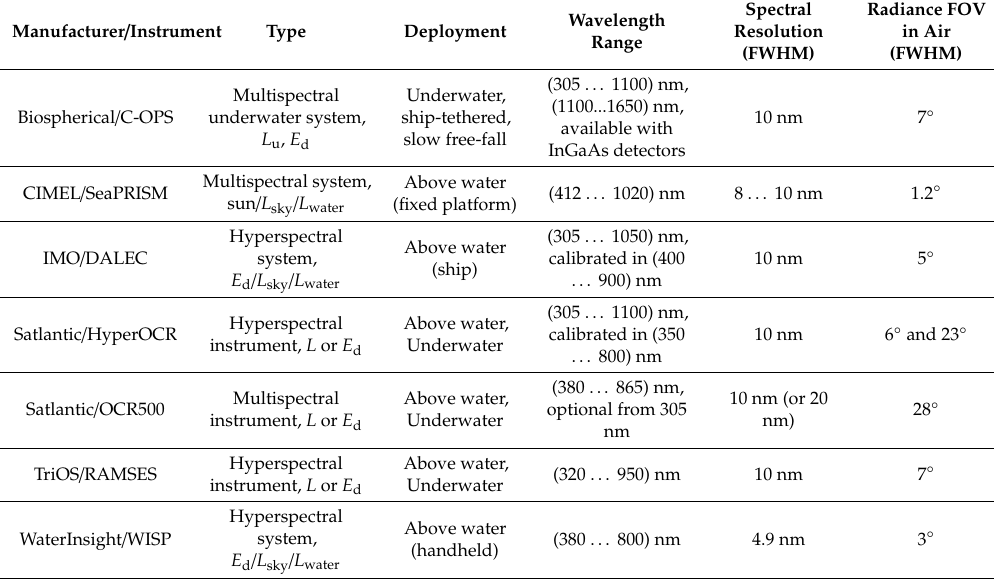
Table 1. Summary of key characteristics of the instruments and systems described in the review ( L represents radiance, and E d represents downwelling